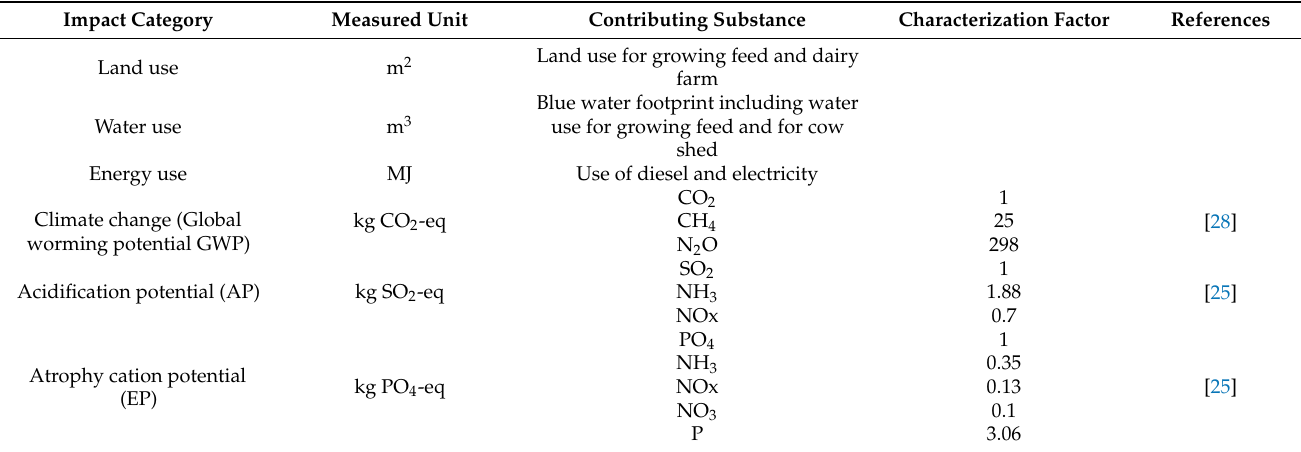
Table 3. The impact categories that were included in the